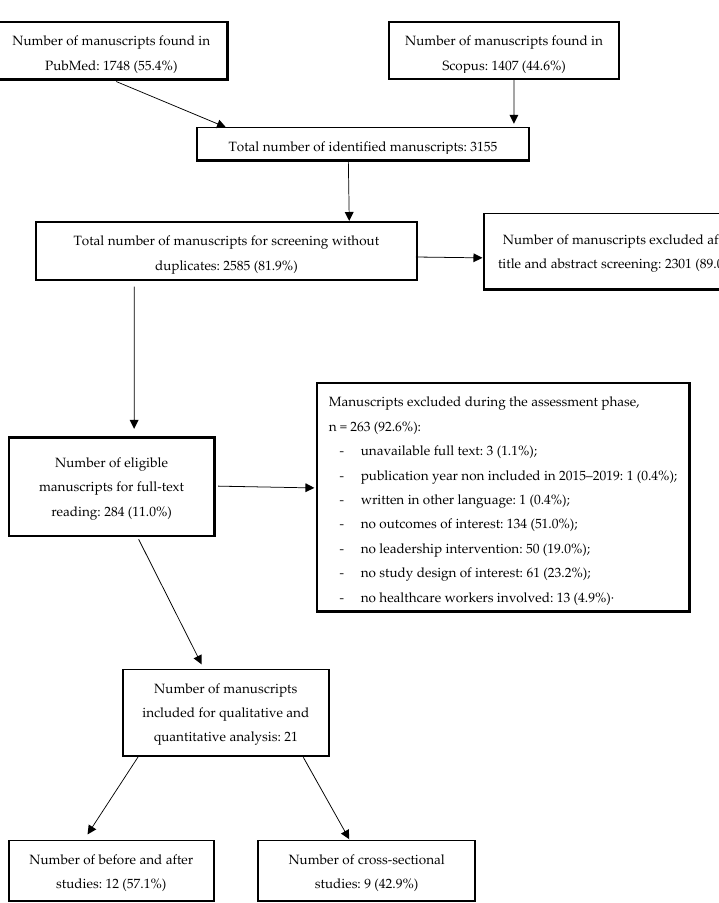
Figure 1. Flow-chart of selection manuscript phases for systematic review and meta-analysis on leadership effectiveness in healthcare workers. 3.2. Leadership Effectiveness in before–after Studies Before–after studies (Supplementary Table S1) involved 22,241 (88.6%, median = 735, IQR = 68–1273) healthcare workers for a total of twelve articles, of which six (50.0%) con- sisted of performance and five (41.7%) of guidelines adherence and one (8.3%) of both outcomes. Among healthcare workers, there were 1,294 nurses (5.8%, median = 647, IQR